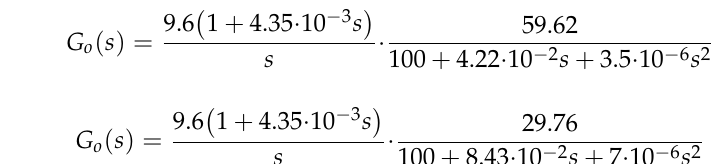
Figure 10. Control block diagram.